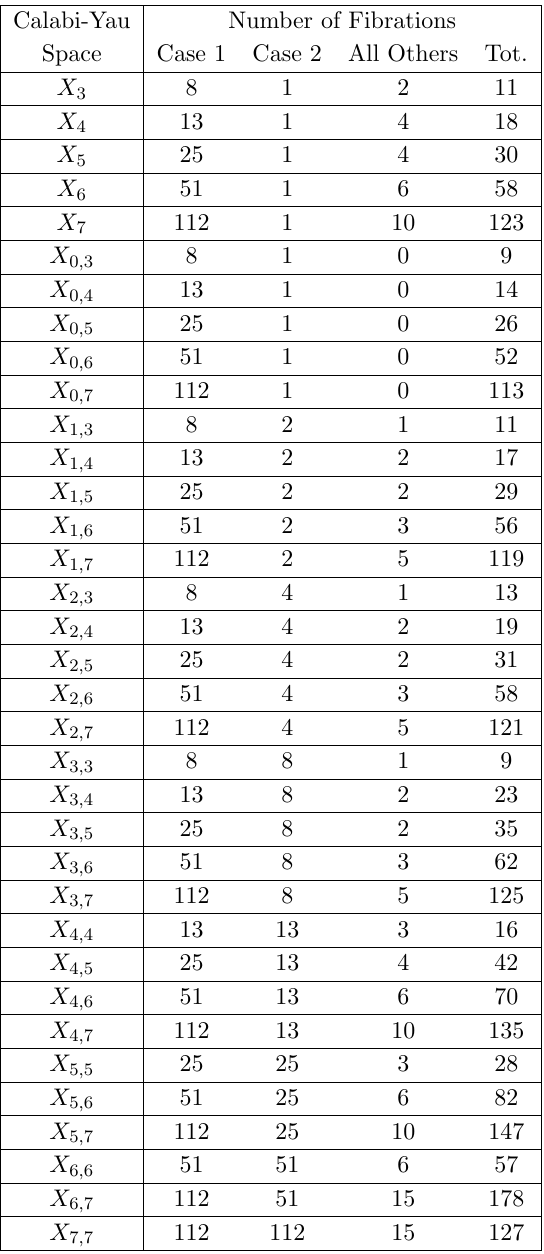
Table 4 . The results from table 3 for genus-one (cid:12)brations for all the Calabi-Yau threefolds in table 1, grouped into families to re(cid:13)ect the symmetries of the del Pezzo ambient spaces. Case 1 and Case 2 denote those (cid:12)brations with the base surface being the second and the (cid:12)rst ambient factor, respectively (incl. all their blow downs); this is consistent with the case distinctions in section 5.1.2. The families are de(cid:12)ned by symmetries including: (a) for Case 1 and Case 2 the (cid:12)brations are only counted up to permutations of the exceptional divisors of the del Pezzo factors; (b) for All Others, up to the obvious permutation symmetries of the ambient space (i.e., permutations of the two P 1 factors in the X s cases and those of the two surface factors in the X r;s cases with r = s ); (c) in the X r;s cases with r = s , the numbers for Case 1 and Case 2 do not add up for the Total counting as only one half of these is regarded as irredundant.